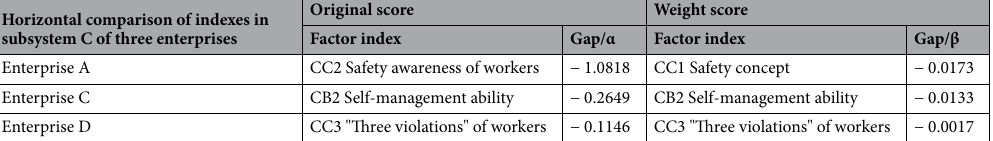
Table 17. Analysis of the shortcomings of the basic index scores of front-line workers’ safety status (subsystem C) in three companies—horizontal comparison.